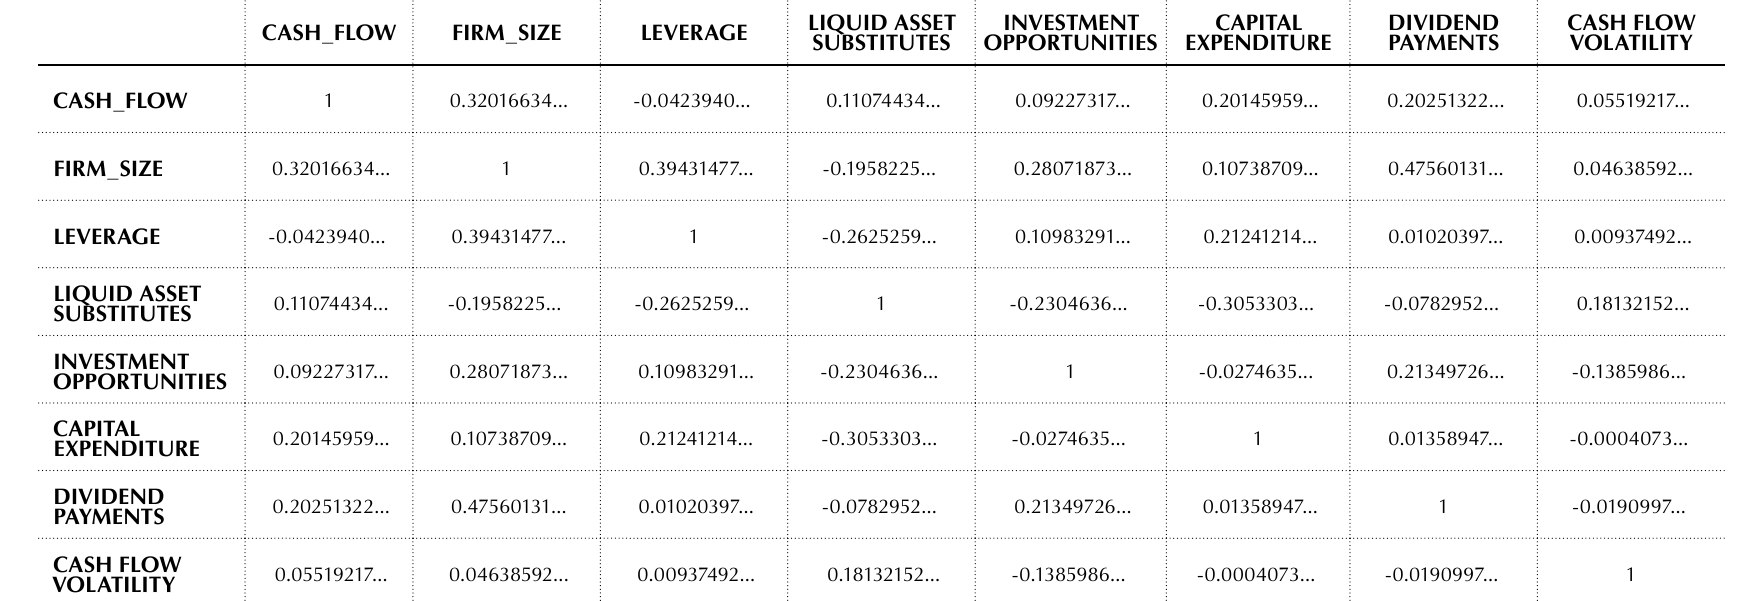
INVESTMENT CAPITAL SUBSTITUTES OPPORTUNITIES EXPENDITURE